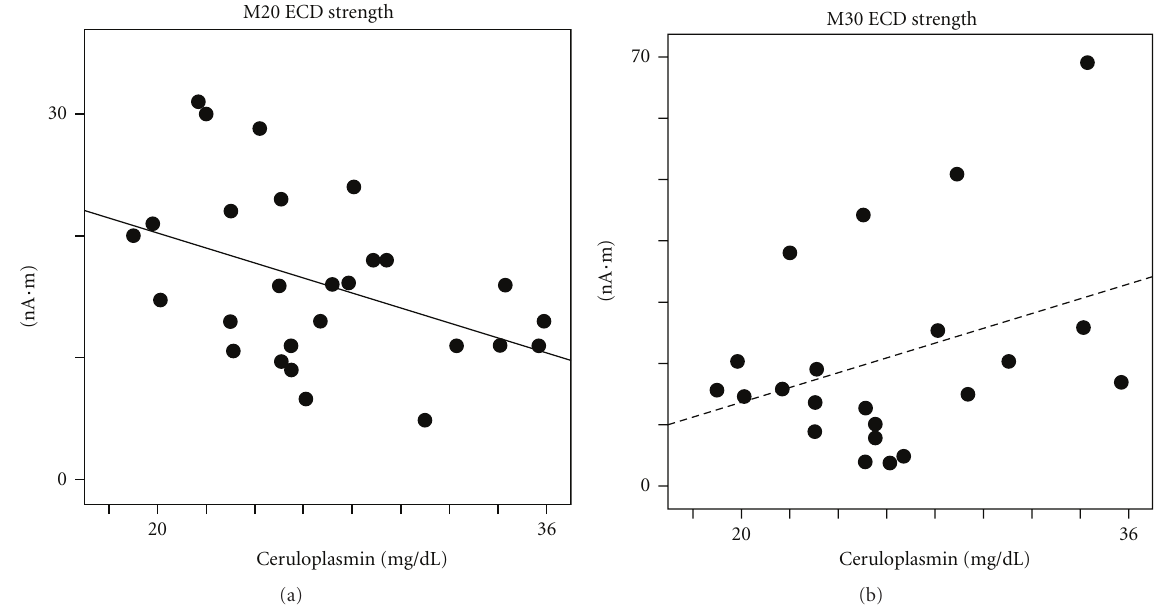
Figure 2: Ceruloplasmin and S1 cortex excitability. Scatter plot of M20 and M30 ECD strengths with respect to individual ceruloplasmin circulating levels. Regression lines are shown for significant (solid line) and nonsignificant (dashed line)